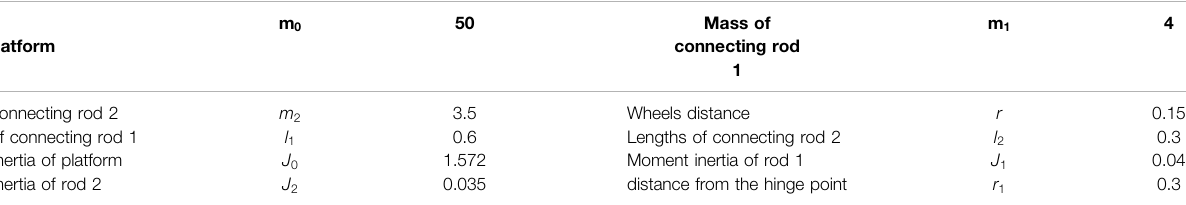
TABLE 1 | Key parameters of mobile platform and connecting rod.